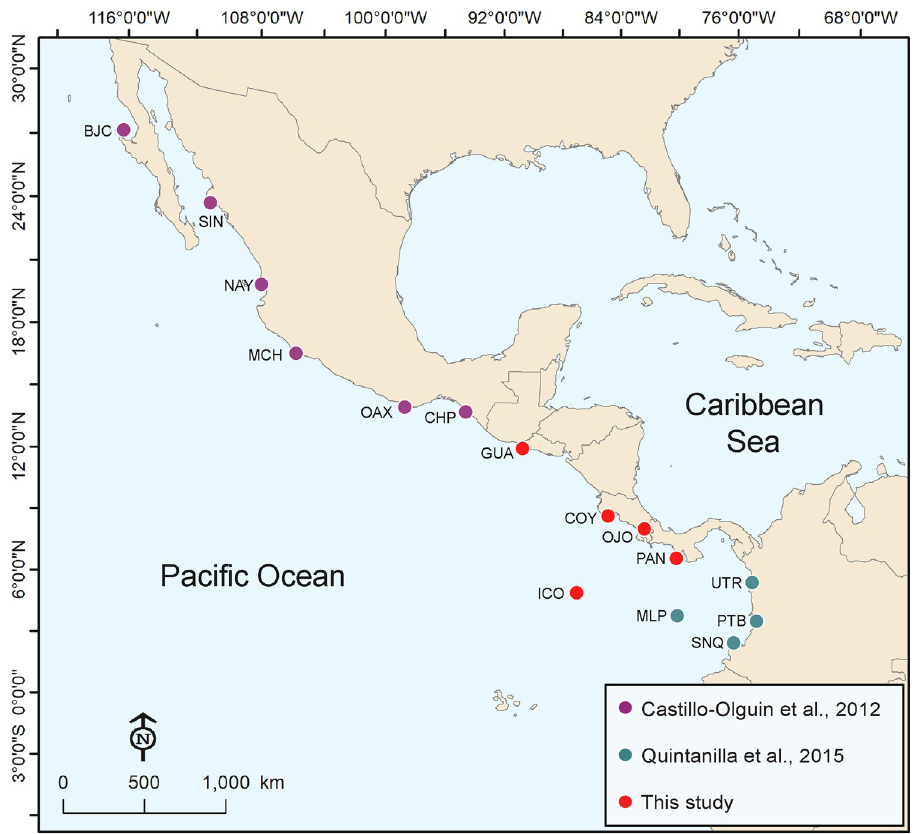
Fig 1. Location of sampling sites of Sphyrna lewini in the Eastern Tropical Pacific. Sampling sites: Guatemala (GUA, N = 72), Ojochal (OJO, N = 43), Coyote (COY, N = 34), Cocos Island (ICO, N = 15), Panama (PAN, N = 65), Nayarit (NAY, N = 25), Oaxaca (OAX, N = 8), Michoacan (MCH, N = 17), Baja California (BJC, N = 25), Chiapas (CHP, N = 14), Sinaloa (SIN, N = 36), Port Buenaventura (PTB, N = 22), Sanquianga (SNQ, N = 20), Utria (UTR, N = 21), Malpelo Island (MLP, N = 18). Sampling sites were plotted using base and raster layers from the Natural Earth (public domain) http://www.naturalearthdata.com/ in ArcMap